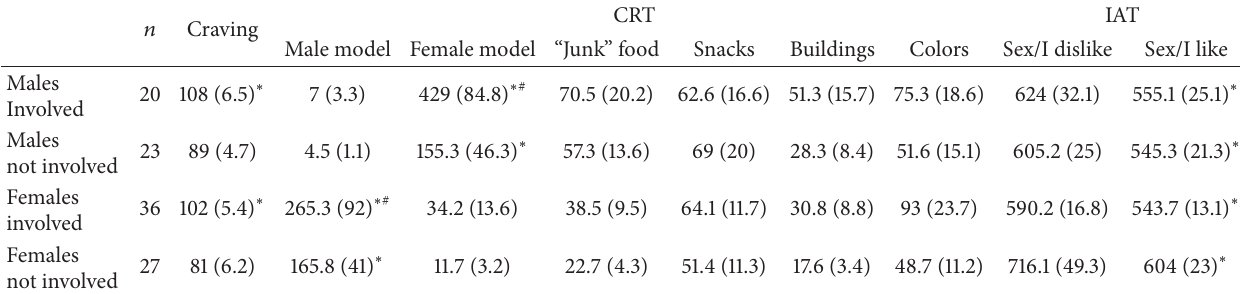
Table 2: Groups, sample size, craving score, and performance on the CRT and IAT in subjects tested in the Sex study